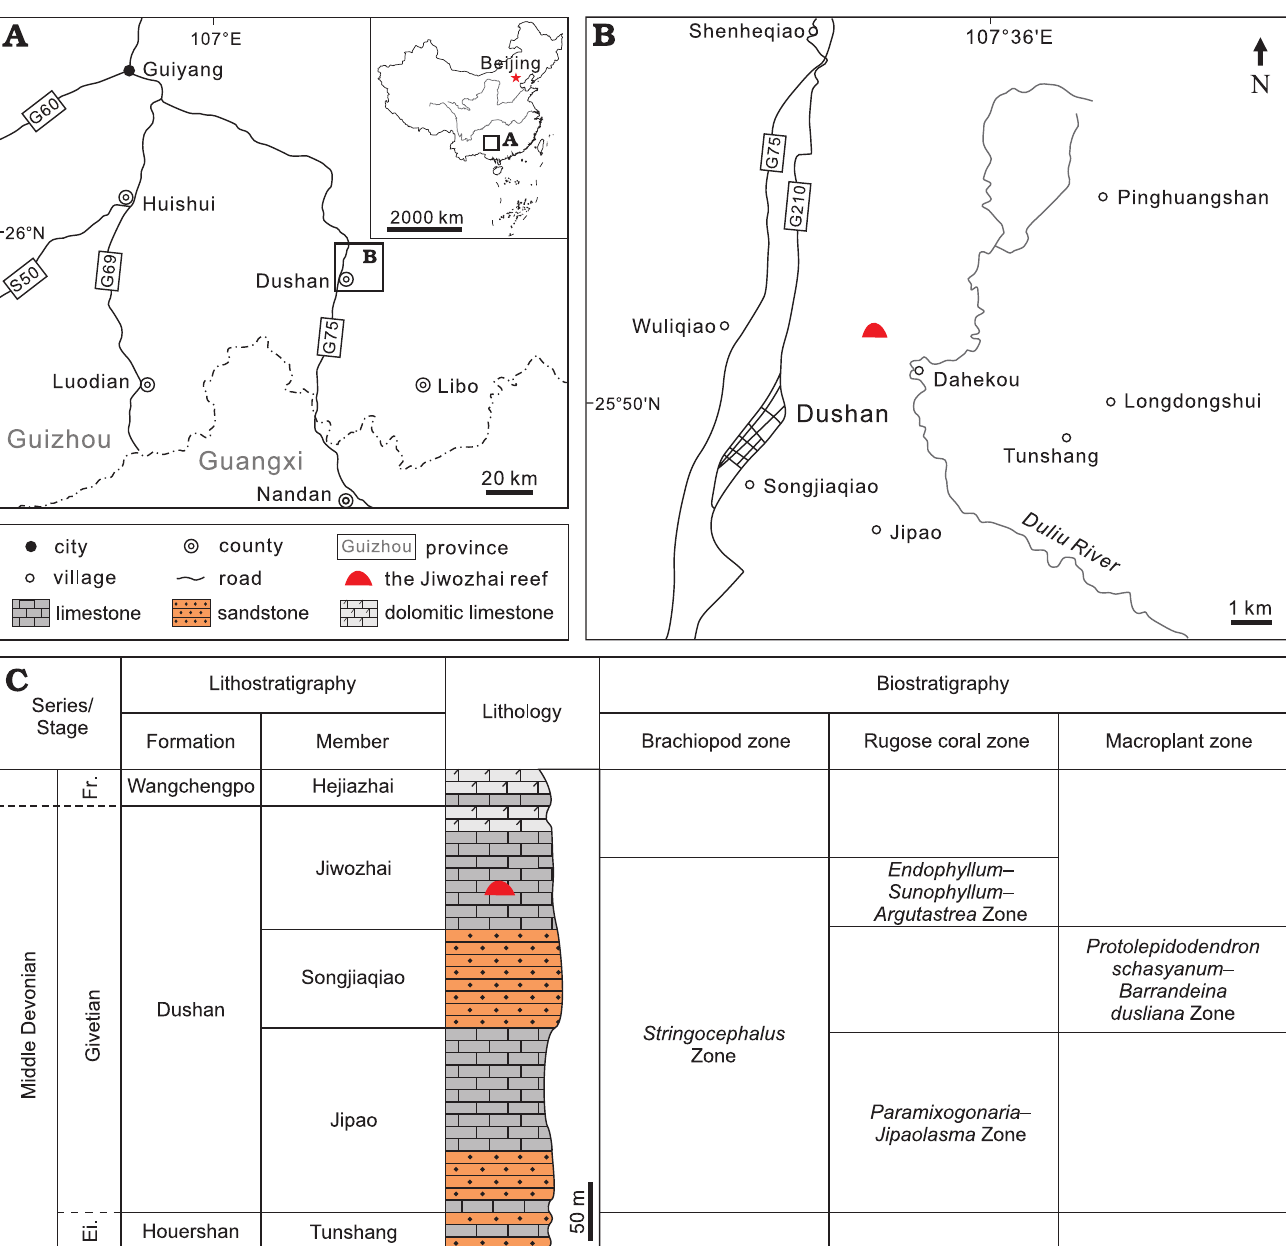
Fig. 1. Location and stratigraphy of the Jiwozhai reef in Dushan County, Guizhou, South China. A . Map showing southern Guizhou and northern Guangxi and the studied area in China. B . Locality of the Jiwozhai reef in Dushan County. C . Depositional successions and fossil assemblages of the supposed up- permost Eifelian to lowermost Frasnian in Dushan, Guizhou province (modified after Liao et al. 1979; Liao 2003). Abbreviations: Ei, Eifelian; Fr.,